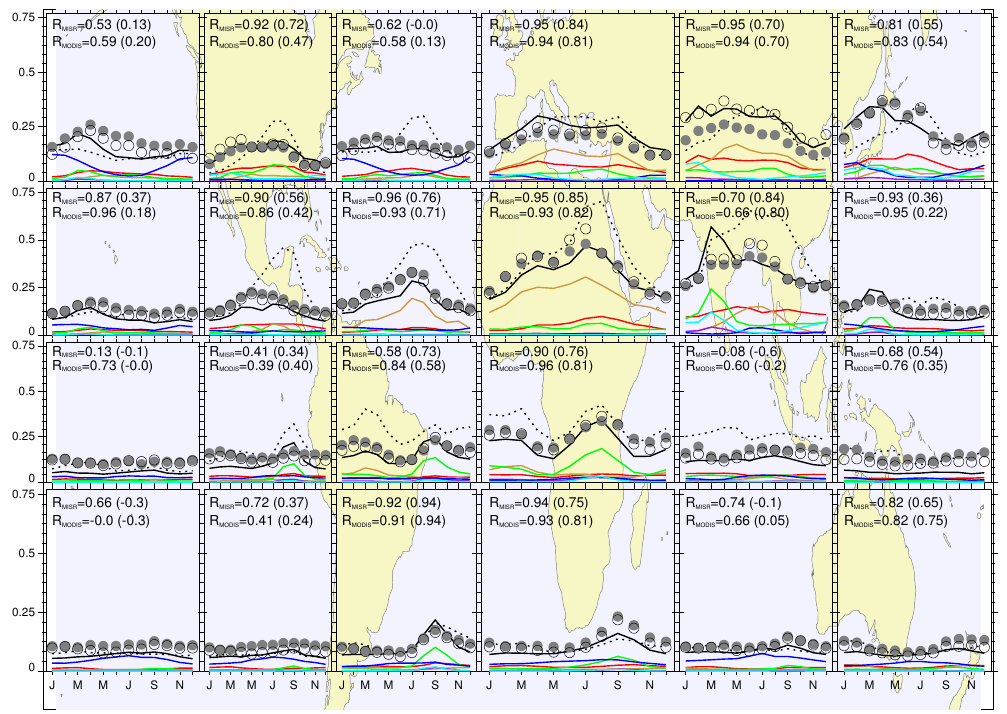
Figure 8. Observed and simulated monthly AOD at 550nm in different regions averaged over the 2008–2010 period. Circles show observa- tions from MODIS (open circles) and MISR (filled circles). The solid and dashed black lines show the AOD simulated by AM3N_fdep_diu and AM3 respectively. We also show the simulated optical depths of sulfate (red), nitrate (cyan), dust (brown), organic carbon (green), black carbon (purple), and sea salt (blue) in AM3N_fdep_diu. The model is sampled to match the location and time of valid measurements by both MODIS and MISR in each region. Correlations between simulated and observed AOD are shown inset for AM3N_fdep_diu and AM3 (in